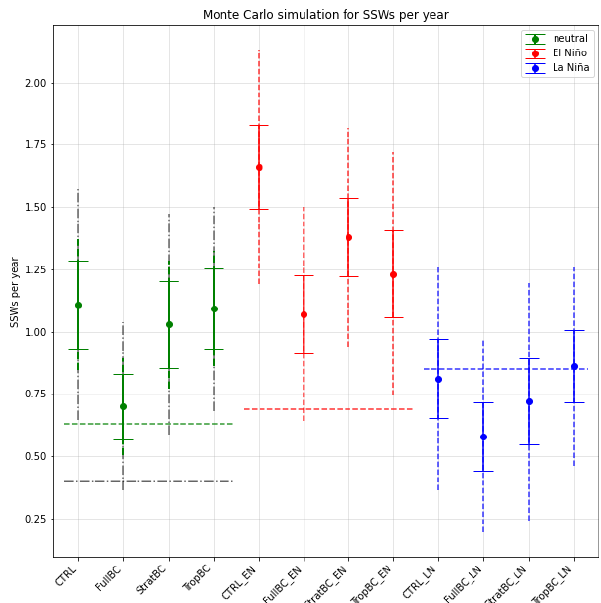
Figure 4. Number of SSWs per year in ECHAM6 and ERA5. The horizontal dashed lines show the ERA5 SSWs per year (green is all 41 years, black dotted–dashed is 15 neutral years, red is 13 El Niño years, blue is 13 La Niña years). Solid error bars show the 5th–95th percentiles for Monte Carlo simulations ( N = 10000) choosing 100 random years from each 100-year simulation. Dashed error bars show the 5th–95th percentiles for Monte Carlo simulations where the number of years chosen matches the number of years in ERA5 (green: all 41 years, black dotted–dashed: 15 neutral years, red: 13 El Niño years, blue: 13 La Niña